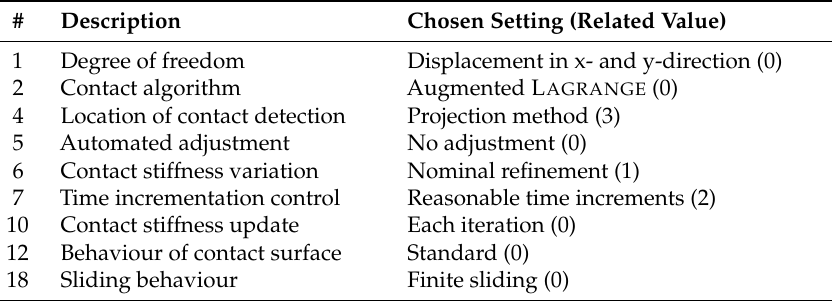
Table 1. Settings of the contact elements TARGE169 and